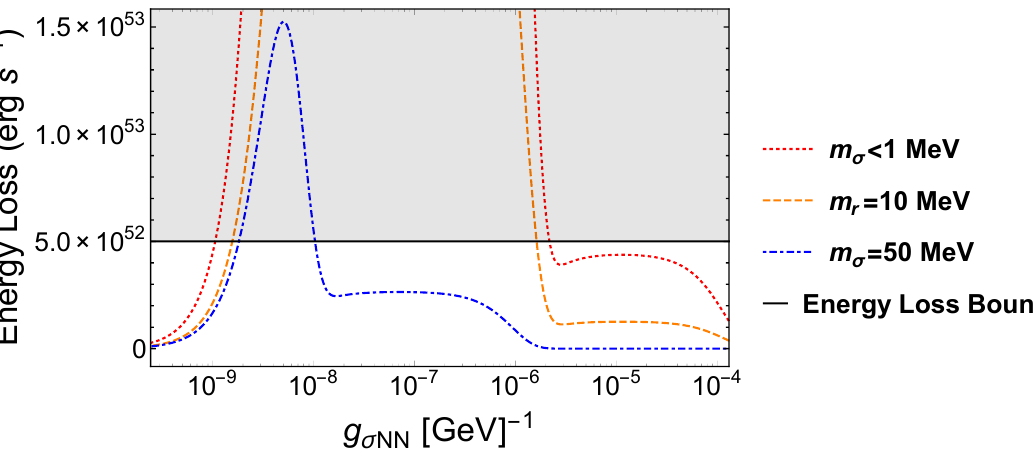
Figure 3. The energy loss rate via radions assuming they only interact with nucleons. The red-dotted line represents a radion mass m (cid:27) = 1 MeV, the orange-dashed m (cid:27) = 10 MeV and the blue-dot-dashed m (cid:27) = 50 MeV. The solid black horizontal line marks the bound (5.1). where (cid:27) is the Stefan-Boltzmann constant and not to be confused with the radion (cid:12)eld. The bound on the energy loss rate (5.1) directly translates to a bound on the